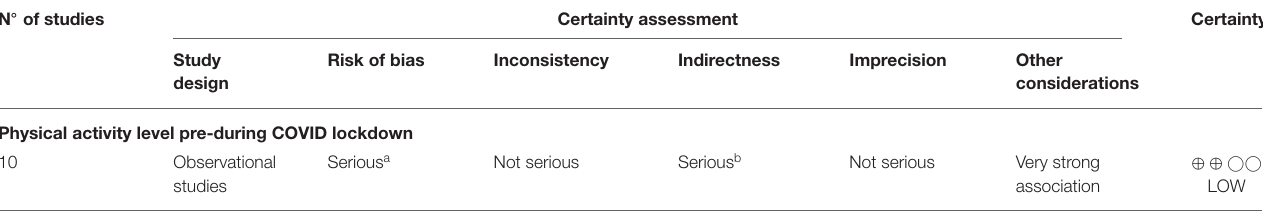
TABLE 3 | Summary of findings